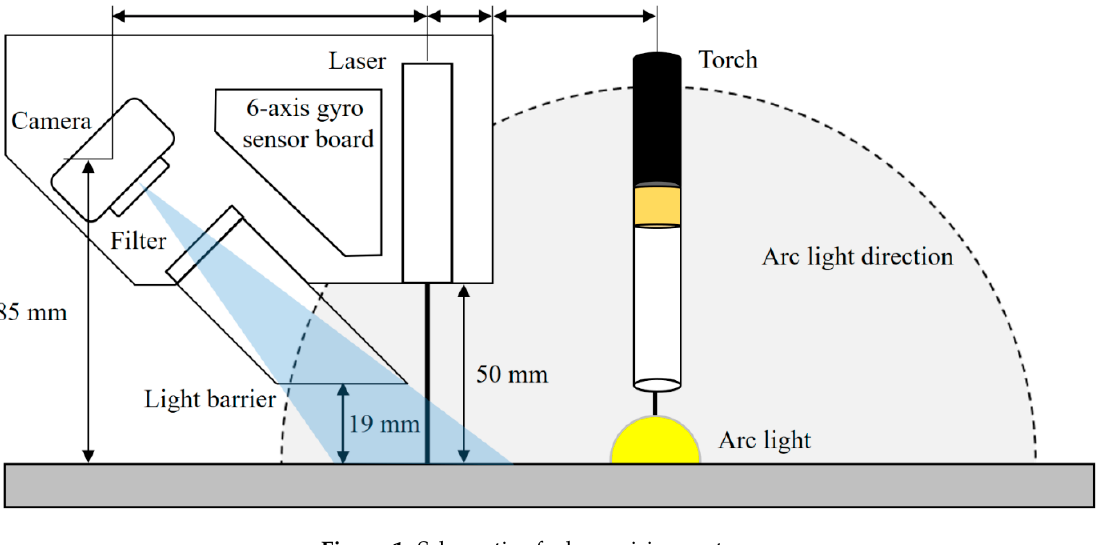
Figure 1. Schematic of a laser vision system.